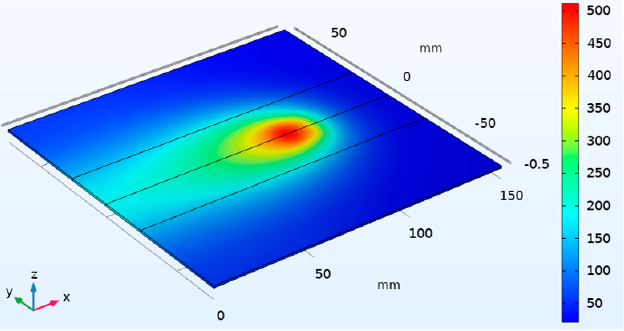
Figure 6. Temperature distribution in the blank after 22 s of surface treatment (T510V5).